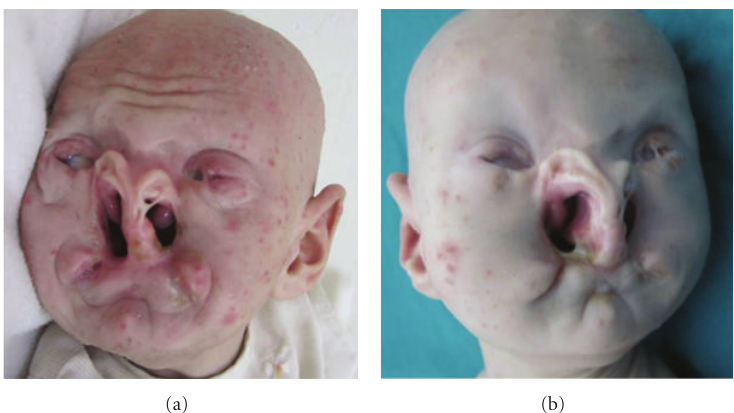
Figure 2: The BPS patient closeup of face showing severe craniofacial anomalies.